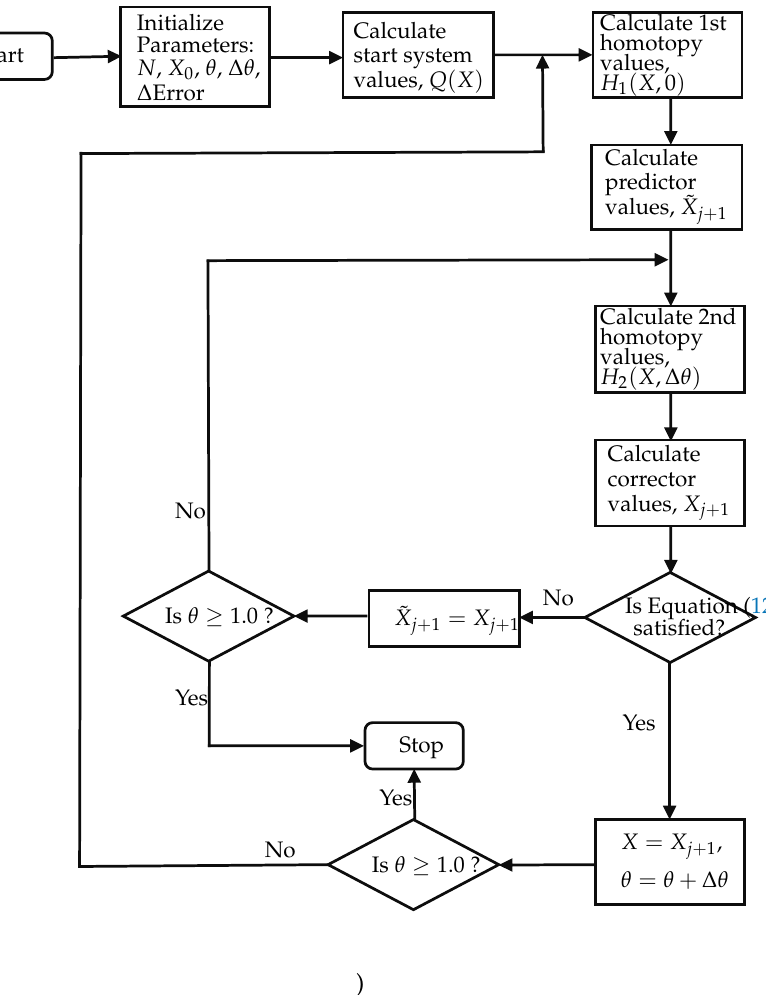
Figure 1. Computational flow of the numerical polynomial homotopy continuation (NPHC)